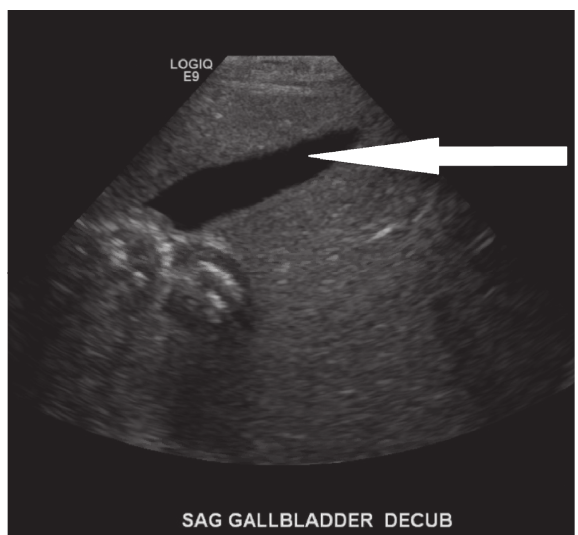
Figure 4: Normal gallbladder with complete resolution of the initial